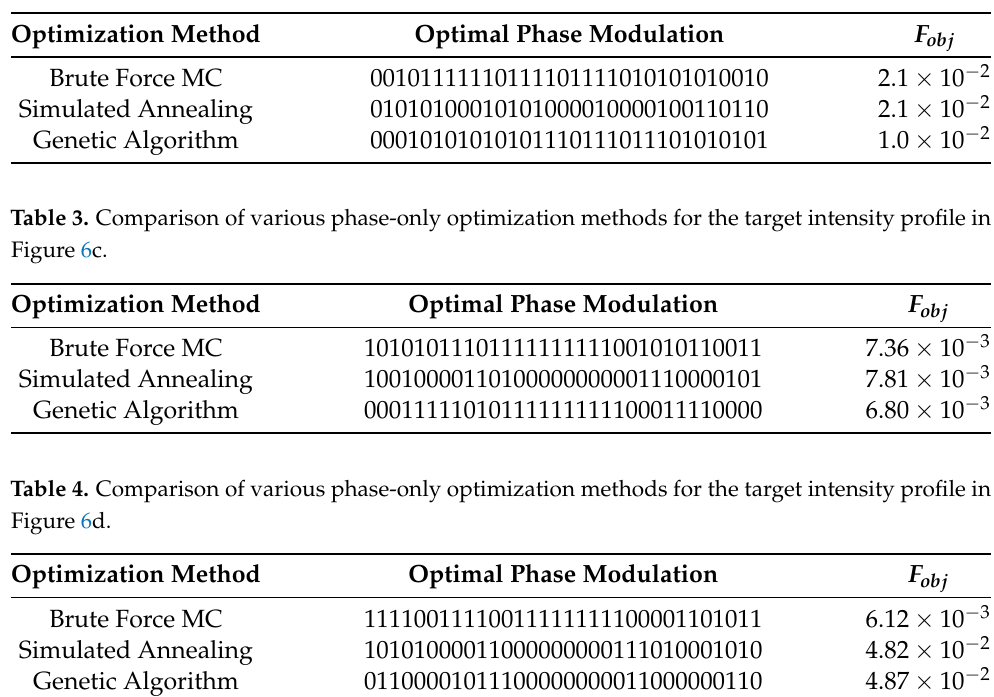
Table 2. Comparison of various phase-only optimization methods for the target intensity profile in Figure 6b.